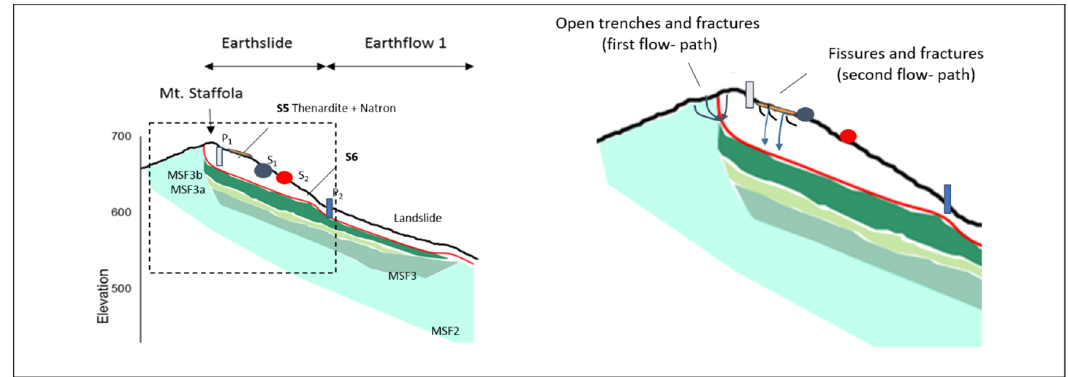
Figure 8. Sketch of the source zone in which the first and second flow-paths (in blue) connected to the main slip surface (in red) were reported.